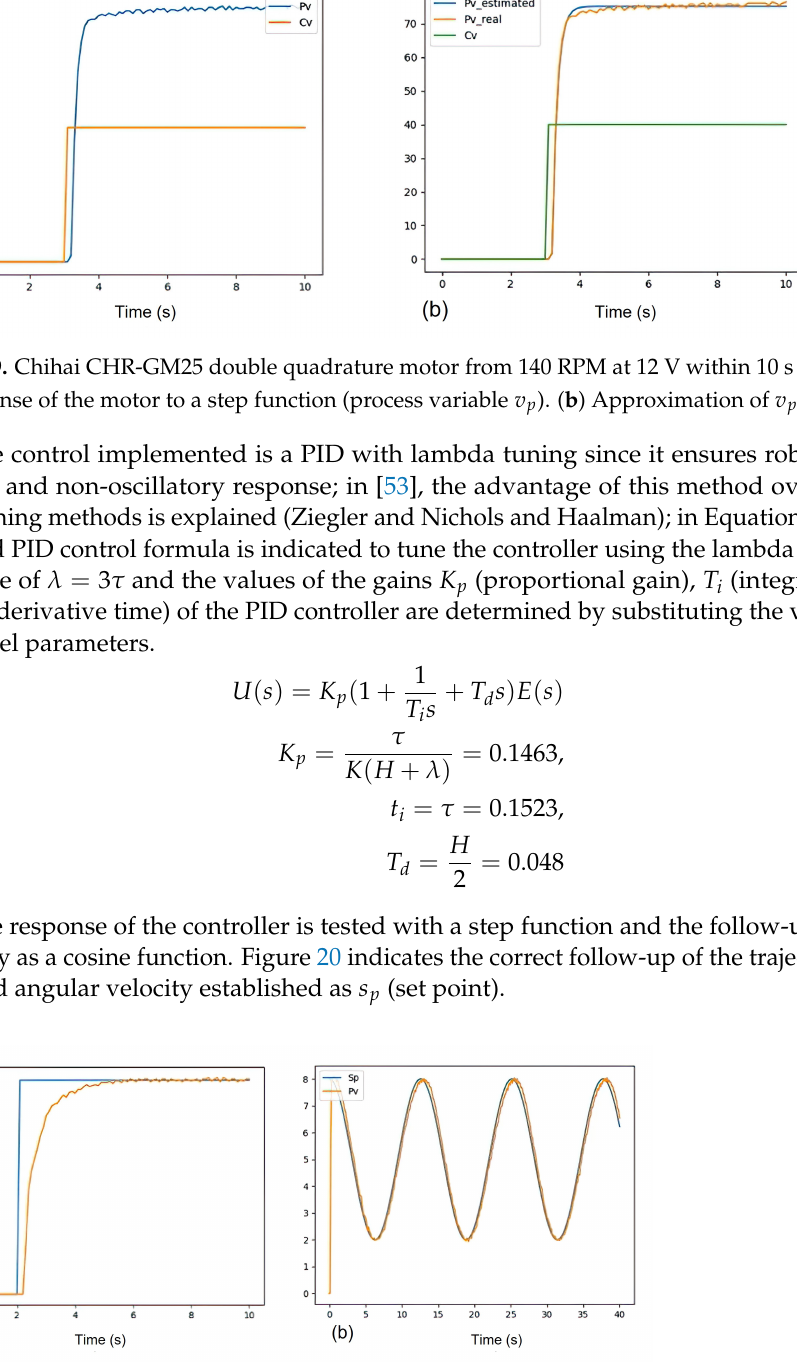
Figure 20. The response of the controller is tested with a step function and the follow-up of the trajectory as a cosine function. ( a ) Response of the PID control with a step function. ( b ) Response of the PID control to track a trajectory represented by the cosine